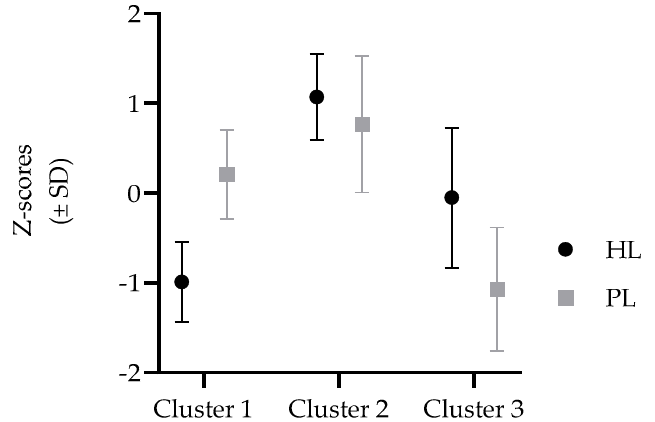
Figure 2. Multivariate clustering on the basis of health literacy (HL) and physical literacy (PL) for girls (results are presented in standardized values).